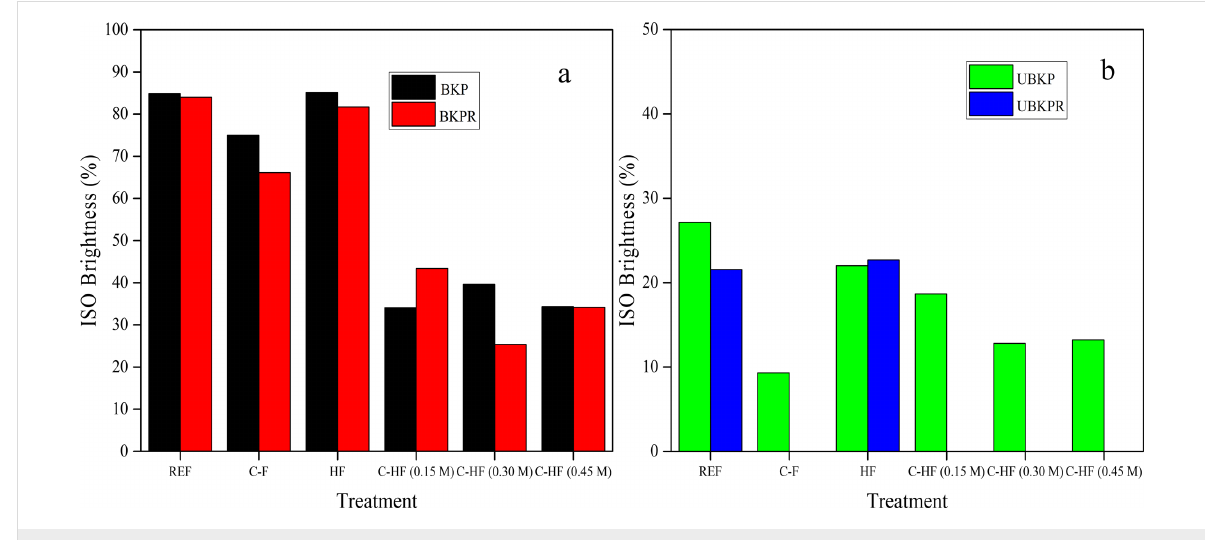
Figure 12: ISO Brightness of (a) BKP and BKP-R and (b) UBKP and UBKP-R.